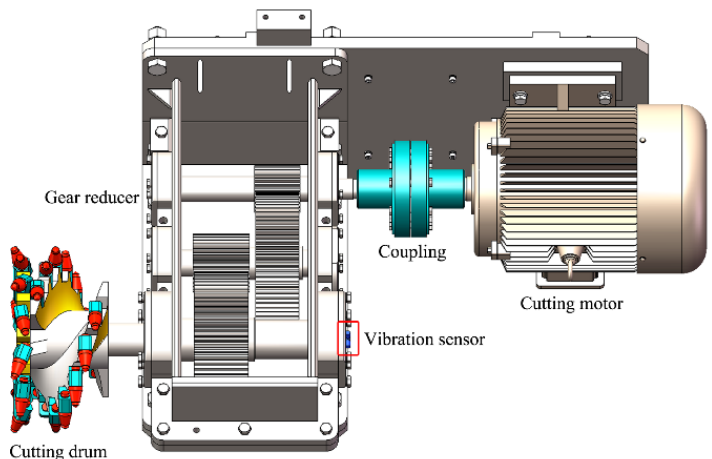
Figure 11. Installation diagram of the vibration sensor.